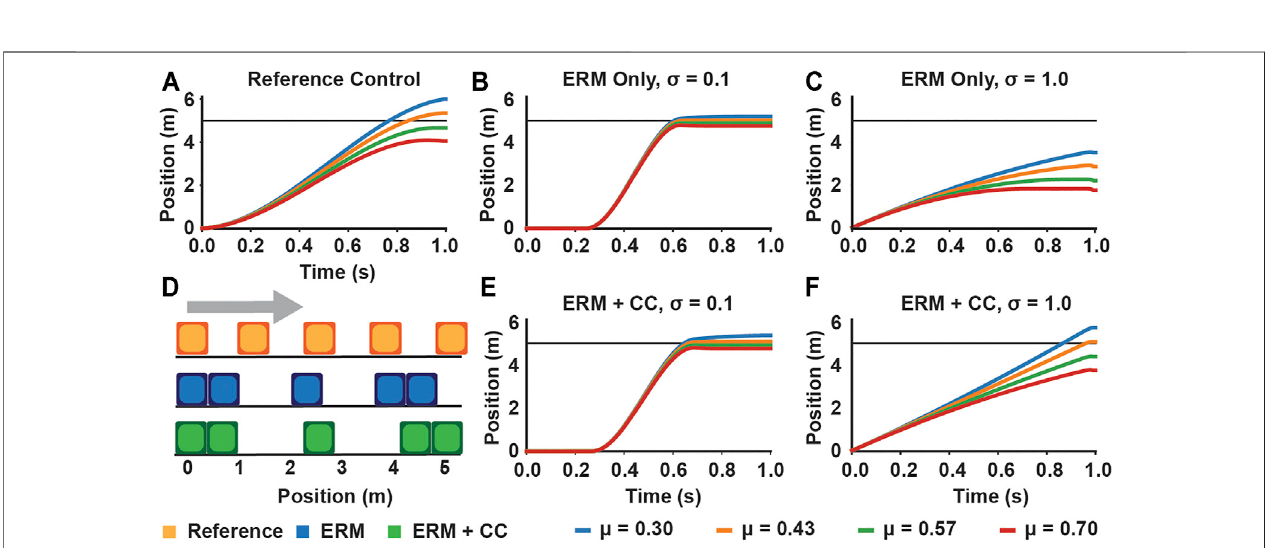
FIGURE 4 | Example block simulations demonstrating chance constraints retain robustness at moderate uncertainty and improve feasibility performance at high uncertainty, compared to the (A) simulations using the reference controls, for four different values of the friction coef fi cient. Simulations using controls generated under onlythecontact-robustERMcostresultinalowspreadaroundthedesiredpositionformoderateuncertainty (B) ,butcanresultinalargeaveragepositionerrorwhenthe frictionuncertaintyislarge (C) .SimulationsusingcontrolsgeneratedusingERMwithchanceconstraints( θ (cid:2) β (cid:2) 0.7)maintainalowspreadatmoderateuncertainty (E) , and have a low fi nal position error at high uncertainty (F) . (D) Illustration of the motion of the block for the reference, ERM, and ERM with chance constraint controls under high friction uncertainty.